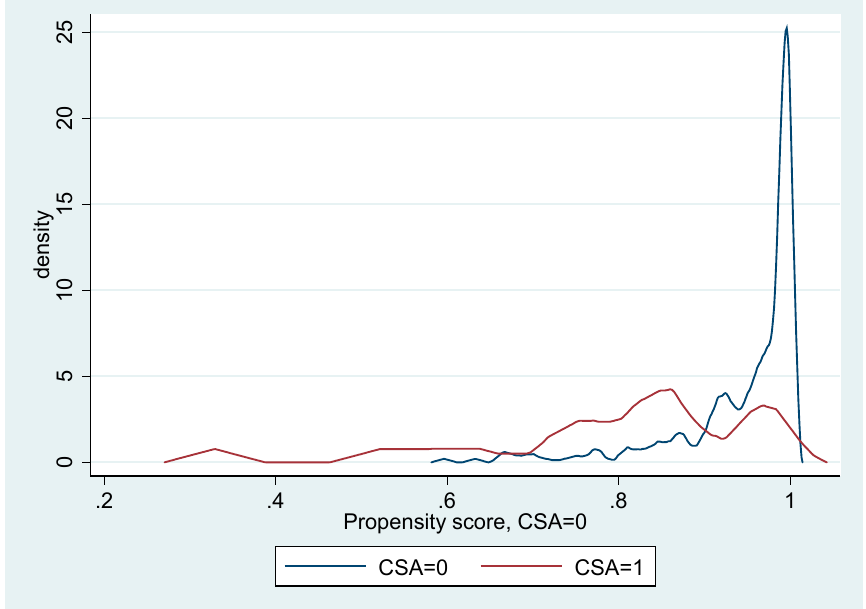
Figure 3. Distribution of propensity scores of CSA.